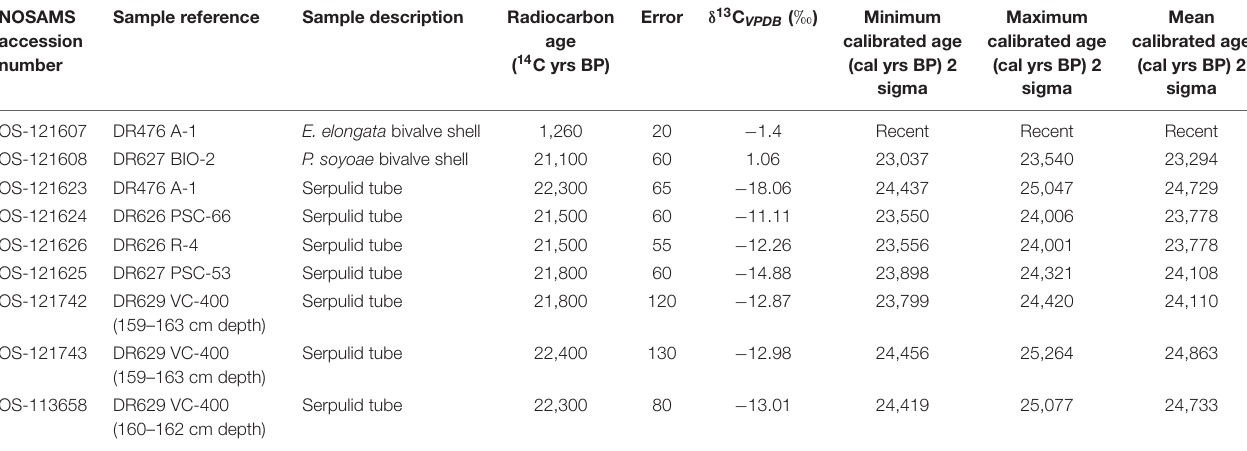
TABLE 1 | Radiocarbon ( 14 C) dates of Fossil Hill bivalve shells and serpulid tubes.